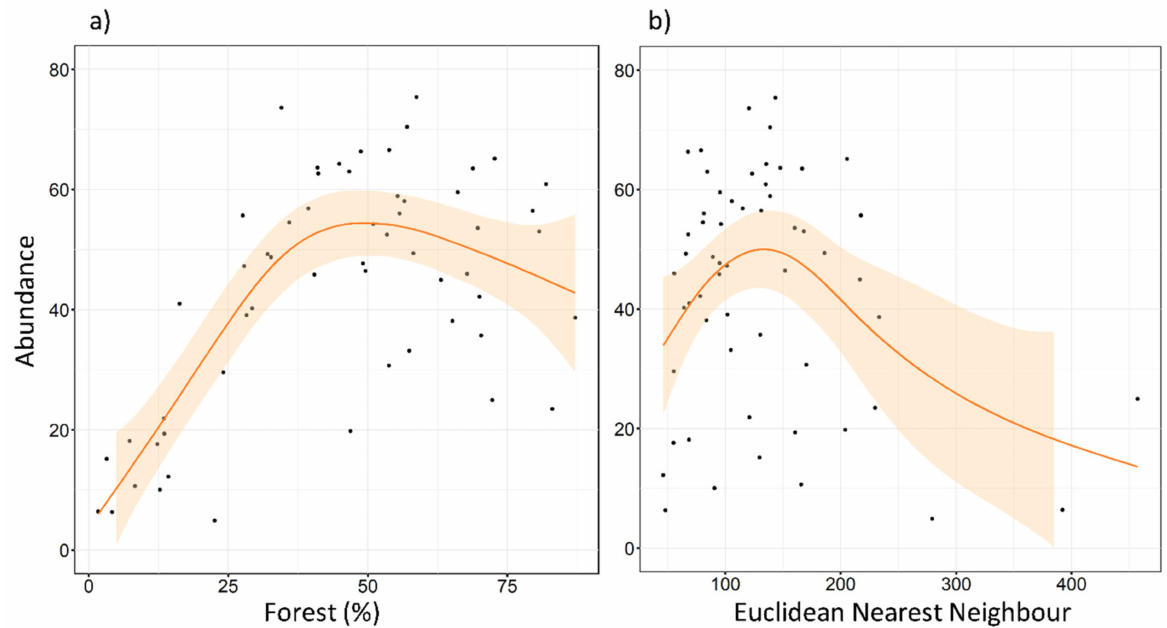
Figure 5. Expected tawny owl ( Strix aluco ) abundance at the landscape scale, based on the top-ranked model along ( a ) a forested gradient, and ( b ) different Euclidean nearest neighbor distances (ENNs) of urban patches. The orange lines show a cubic smoothing spline fitted to the data to show the general trend, while shaded areas show standard error